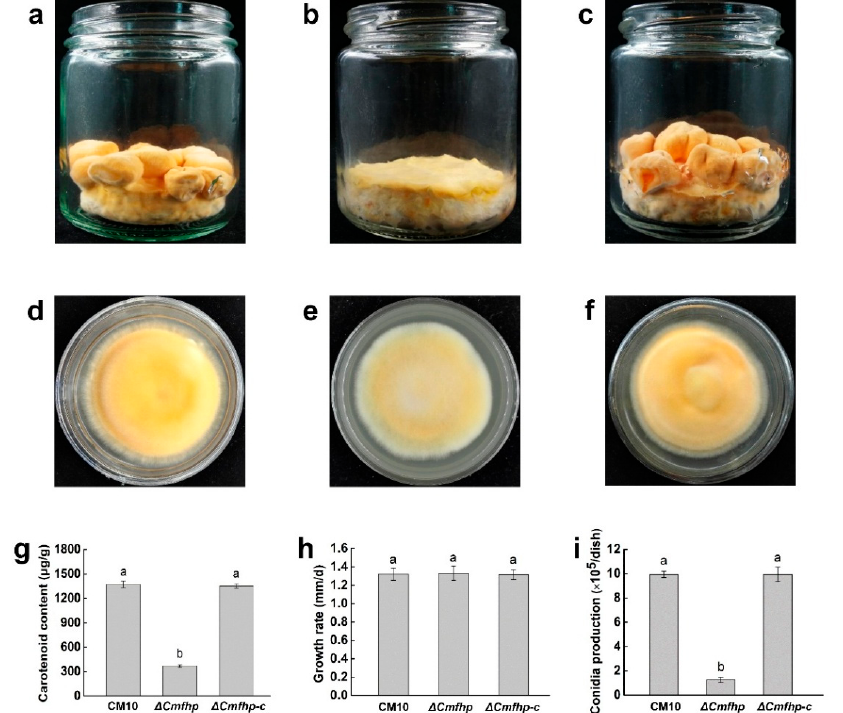
Figure 5. Phenotypic analysis of C. militaris . ( a ) C. militaris CM10 cultured on rice medium. ( b ) C. militaris Δ Cmfhp cultured on rice medium. ( c ) C. militaris Δ Cmfhp-c cultured on rice medium. ( d ) C. militaris CM10 cultured on potato dextrose agar (PDA) medium. ( e ) C. militaris Δ Cmfhp cultured on PDA medium. ( f ) C. militaris Δ Cmfhp-c cultured on PDA medium. ( g ) Analysis of the carotenoid